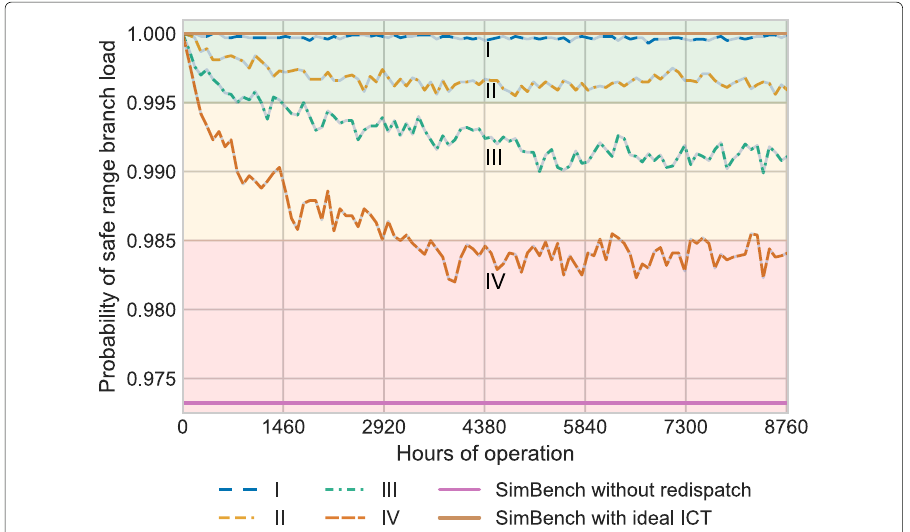
Fig. 10 Probability of all branches being kept in safe range only using redispatch as a counter measure and the chosen state change thresholds at 0.995 and